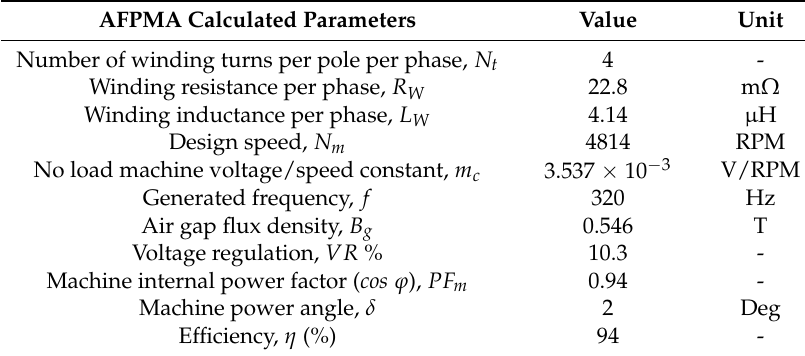
Table 3. AFPMA Calculated Parameters.